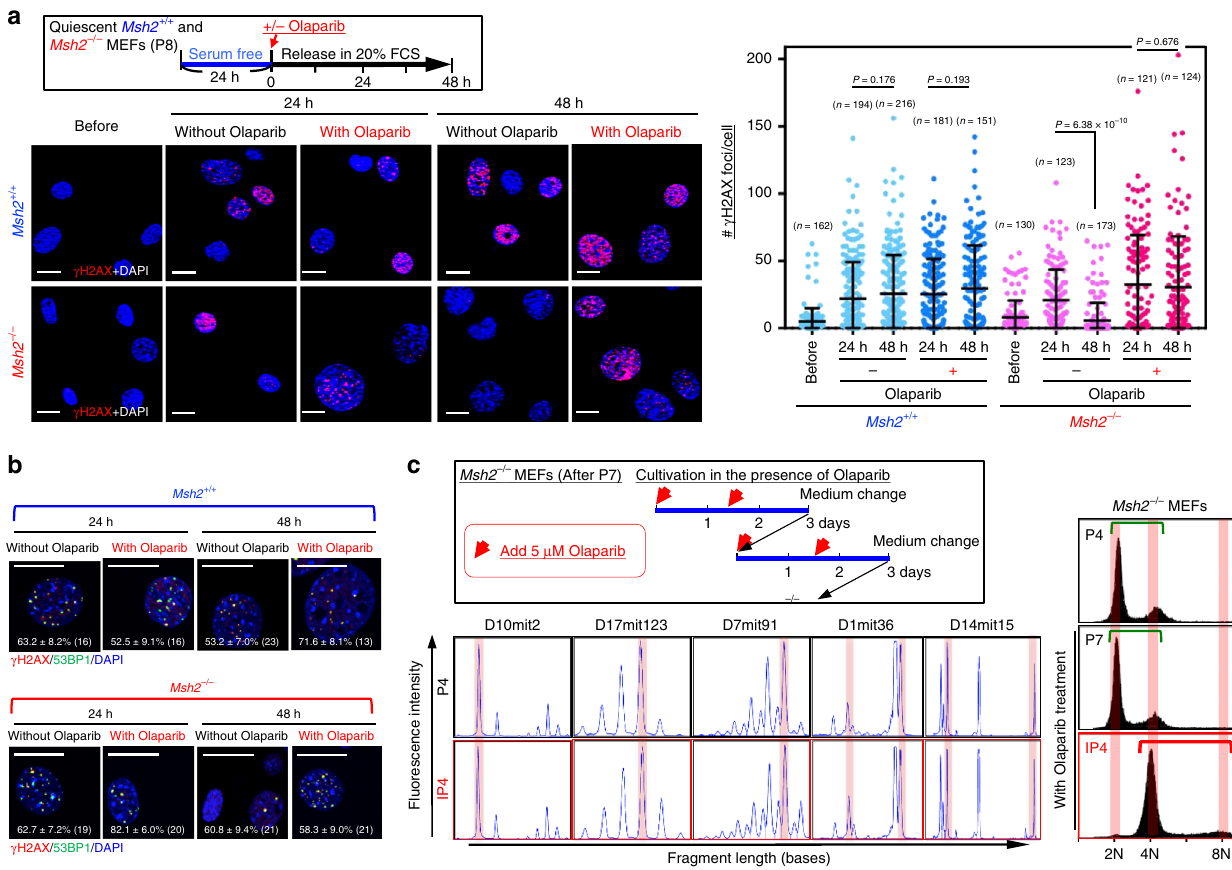
Fig. 5 PARP mediates repair of replication stress-associated DSBs and MSI induction in Msh2 − / − MEFs. a , b Msh2 + / + and Msh2 − / − MEFs were treated according to the work fl ow (upper box). γ H2AX foci ( a n numbers are indicated in graph) and γ H2AX/53BP1 foci ( b ) were detected by immuno fl uorescence. Percentages of γ H2AX foci merged with 53BP1 foci (means ± s.e.) are indicated in each image ( b ). Bars show means ± s.d. Scale bars, 10 μ m. Two-tailed Welch ’ s t -test was used for statistical analysis. c Msh2 − / − MEFs were cultivated under the Std-3T3 protocol and continuously treated with Olaparib, and their CIN-induction and MSI statuses were monitored. The MSI status was determined at the indicated loci. The CIN-induction status was determined by fl ow cytometry. Green and red bars indicate diploidy and tetraploidy,